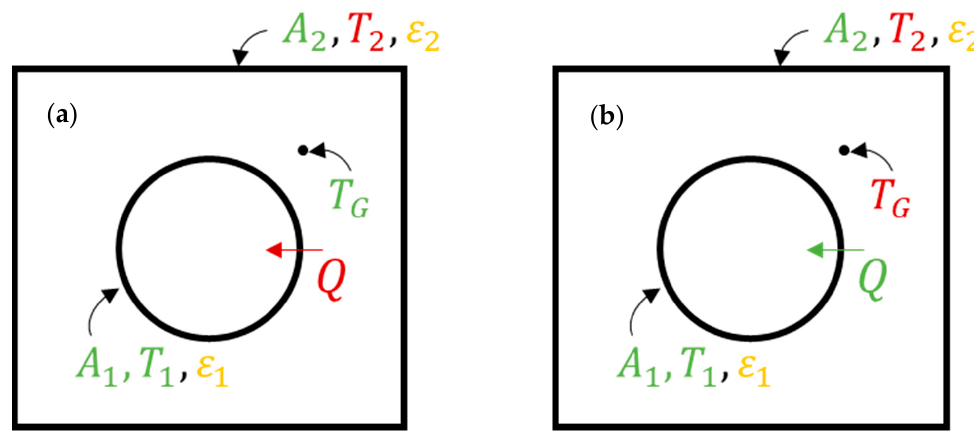
Figure 4. Tube-in-box model where ( a ) a constant gas phase temperature, T G , is assumed for varying tube, ε 1 , and adiabatic surface, ε 2 , emissive properties and ( b ) the gas phase temperature, T G , is adjusted to get the same heat flux, Q , again for varying ε 1 and ε 2 .